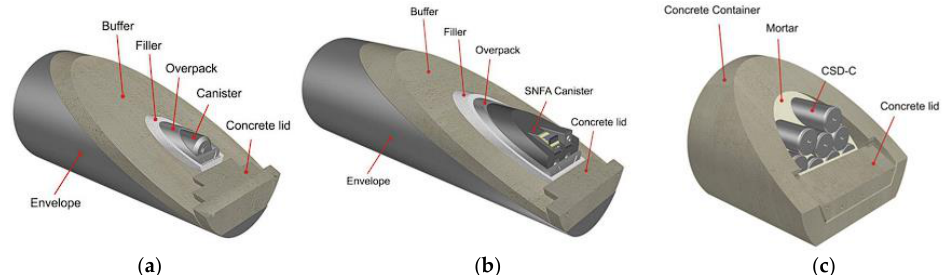
Figure 2. Construction of «supercontainers» for high- ( a , b ) and long-lived low- and intermediate-level radioactive waste, and monolith ( c ) for long-lived low- and intermediate-level waste disposal